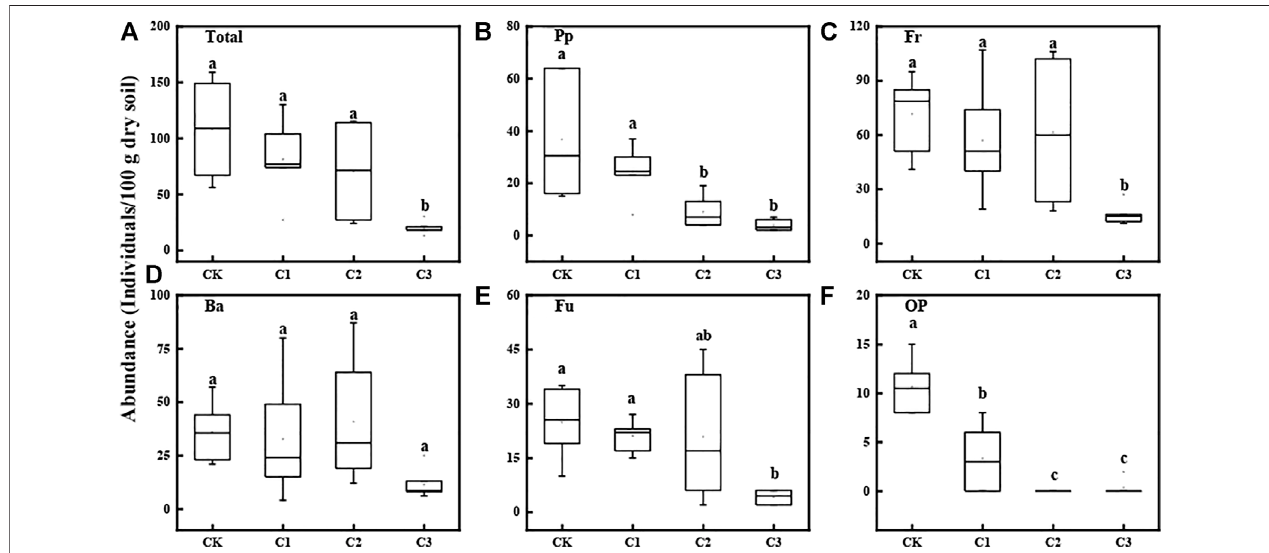
FIGURE1 | Abundances (specimens/100 gdrysoil) oftotal nematodes (A) , plant-feeding nematodes (B) , free-living nematodes (C) , bacterial-feeding nematodes (D) , fungal-feeding nematodes, (E) and ominous – carnivorous nematodes (F) at the depths of 0 – 20 cm soils exposed to varying magnitudes of microplastic pollution. Thebox-plotshowsthemin,lowerquartile,median,mean,andupperquartilevalues,andthewhiskersshowtherangeofthevariation.Differentlowercaselettersshowa signi fi cant difference ( p < 0.05) across treatments. CK: no microplastics added to the soil; C1:75 g of microplastics added to the soil (0.5%, w/w); C2: 150 g of microplastics added to the soil (1%, w/w), and C3: 300 g of microplastics added to the soil (2%, w/w).